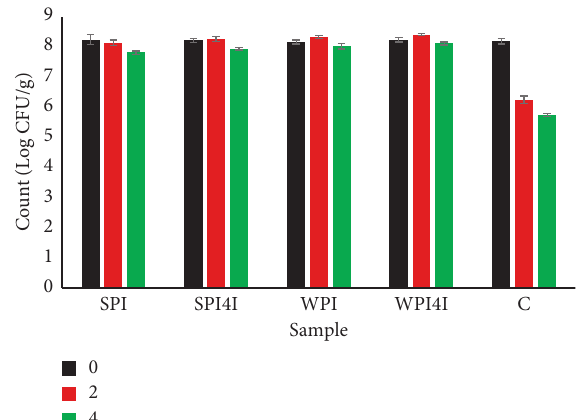
Figure 4: Effect of NaCl (0, 2 and 4%) on the viability of L. reuteri encapsulated within different wall materials; SPI (soy protein isolate 20%), SPI4I (soy protein isolate 20% +inulin 4%), WPI (whey protein isolate 20%), WPI4I (whey protein isolate 20% +inulin 4%), and C (free bacteria).